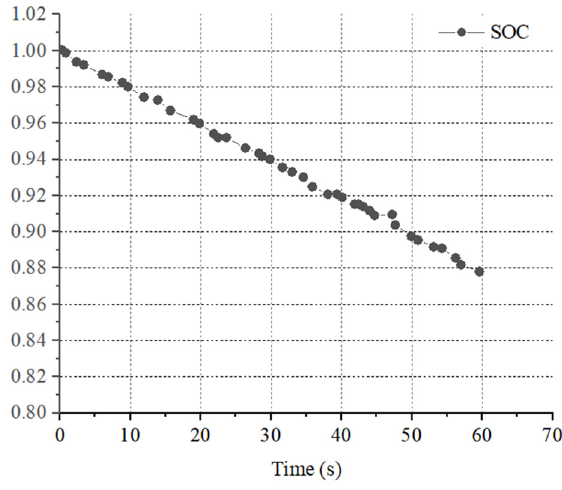
Figure 19. Battery SOC.